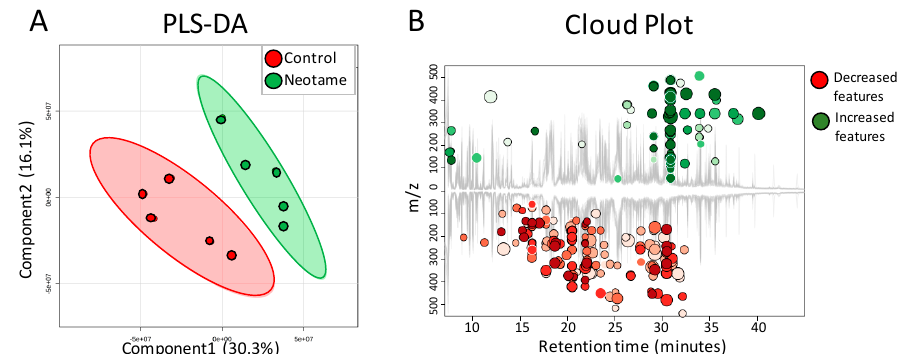
Figure 4. ( A ) PLS-DA analysis shows that the fecal metabolite profiles are different between control ( n = 5) and neotame-treated animals ( n = 5); ( B ) Cloud Plot gives the ion features that have significantly different ( p ≤ 0.05, fold change ≥ 1.5) abundance between control and neotame-treated animals.